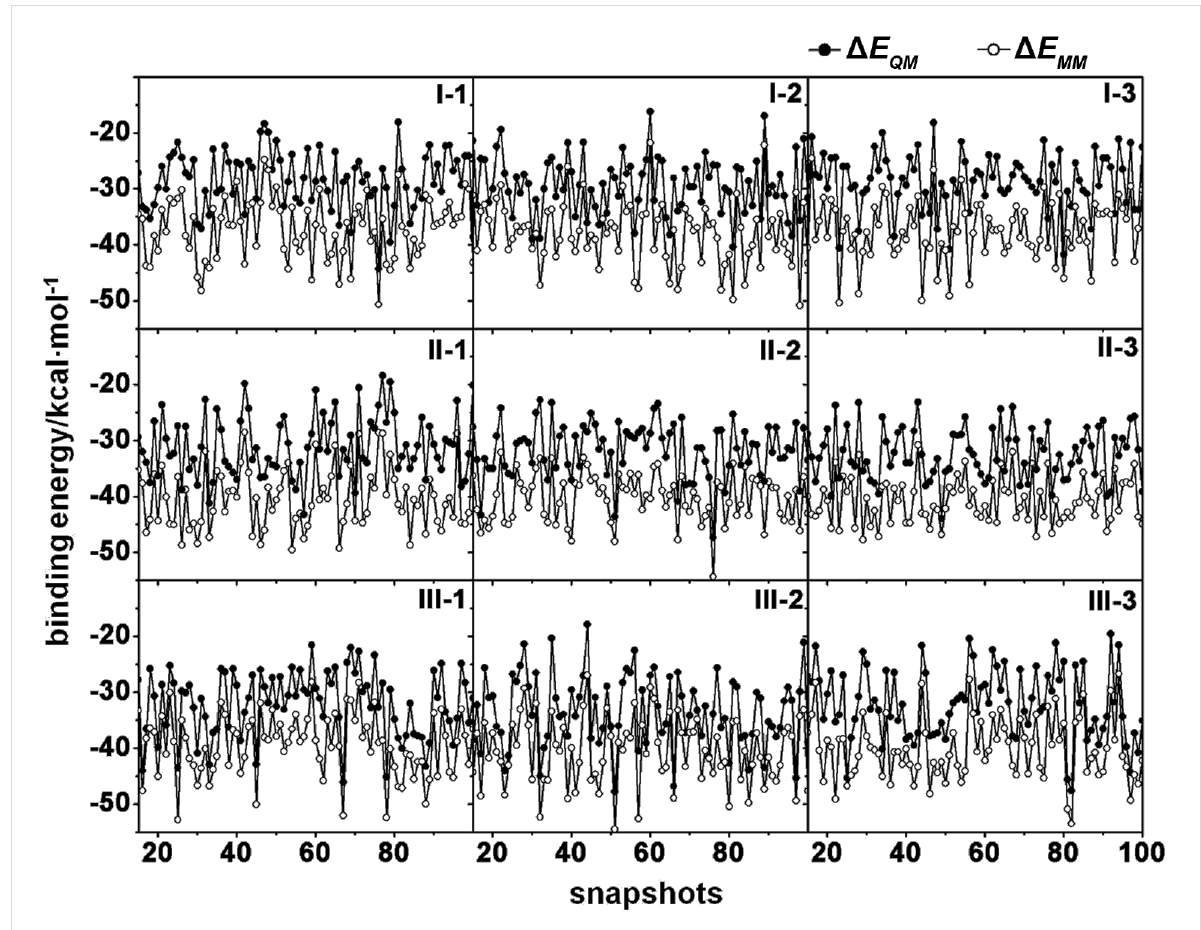
Figure 7: Comparison between QM and MM energies ( ∆ E QM and ∆ E MM ) per the same set of 100 MD snapshots in the three formed inclusion complexes I–III .